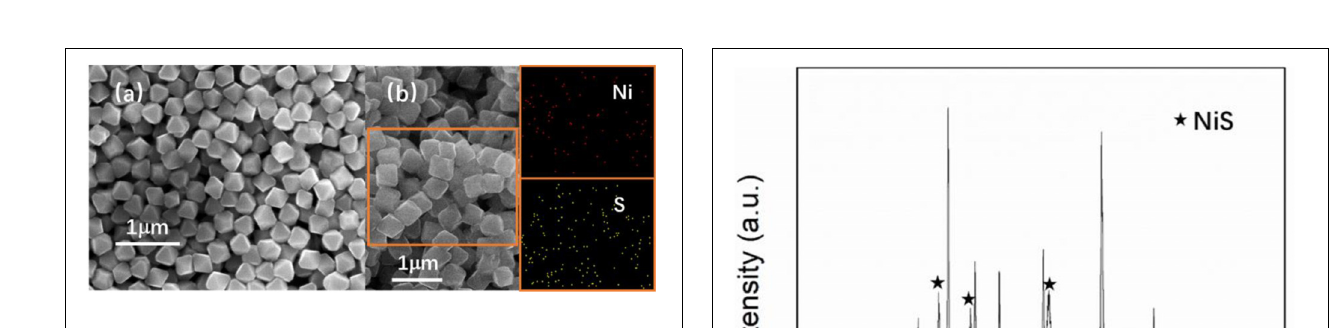
FIGURE 1 | Experimental preparation flow chart.